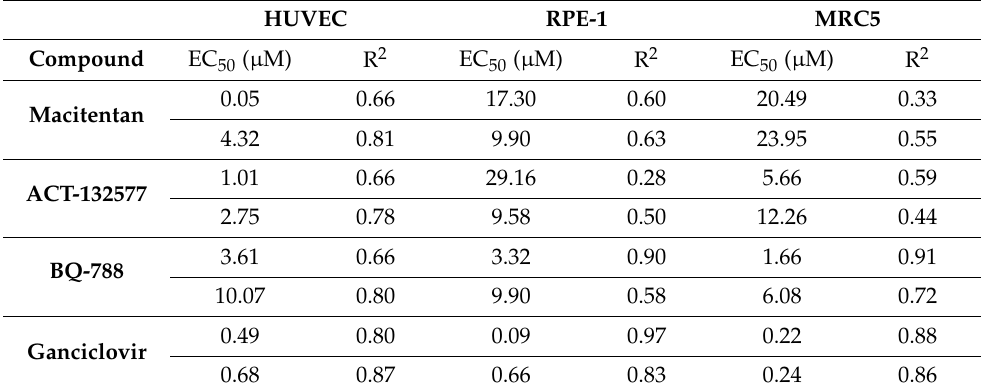
Table 4. EC 50 for inhibition of infectious viral